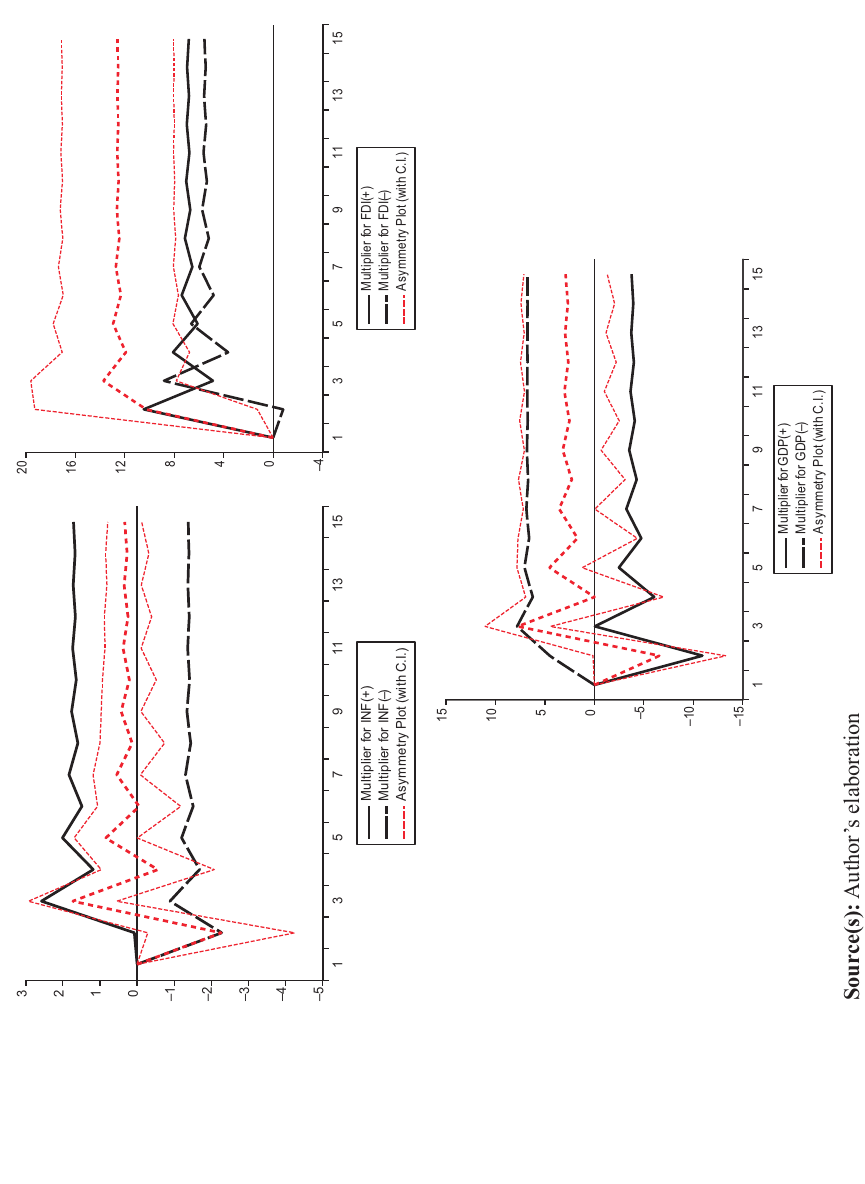
Figure 2. Dynamic multiplier